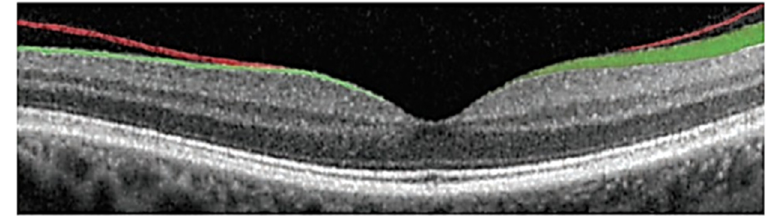
Figure 5. RNFL (green) and posterior vitreous layer (red).